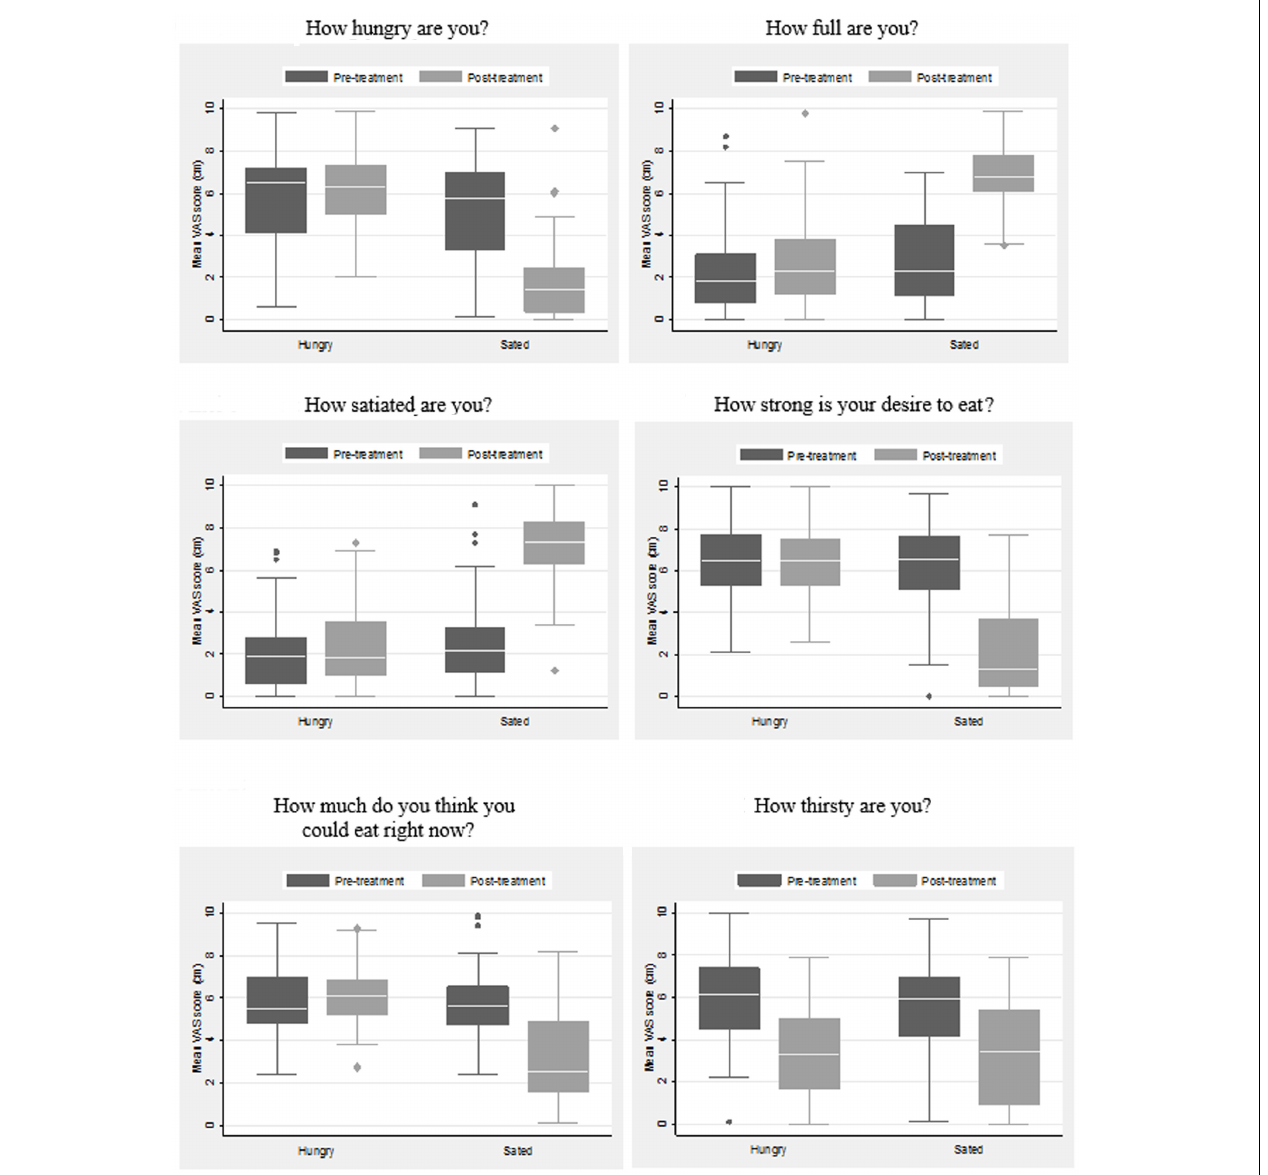
FIGURE 1 | Box plots from Visual Analog Scale questions for control (hungry) and treatment (sated) conditions. The box indicates middle quartiles and white line denotes median. Bar widths show the range and dots show outlying observations. N = 101 (49 in the hungry condition and 52 in the sated condition). Values in y -axis are